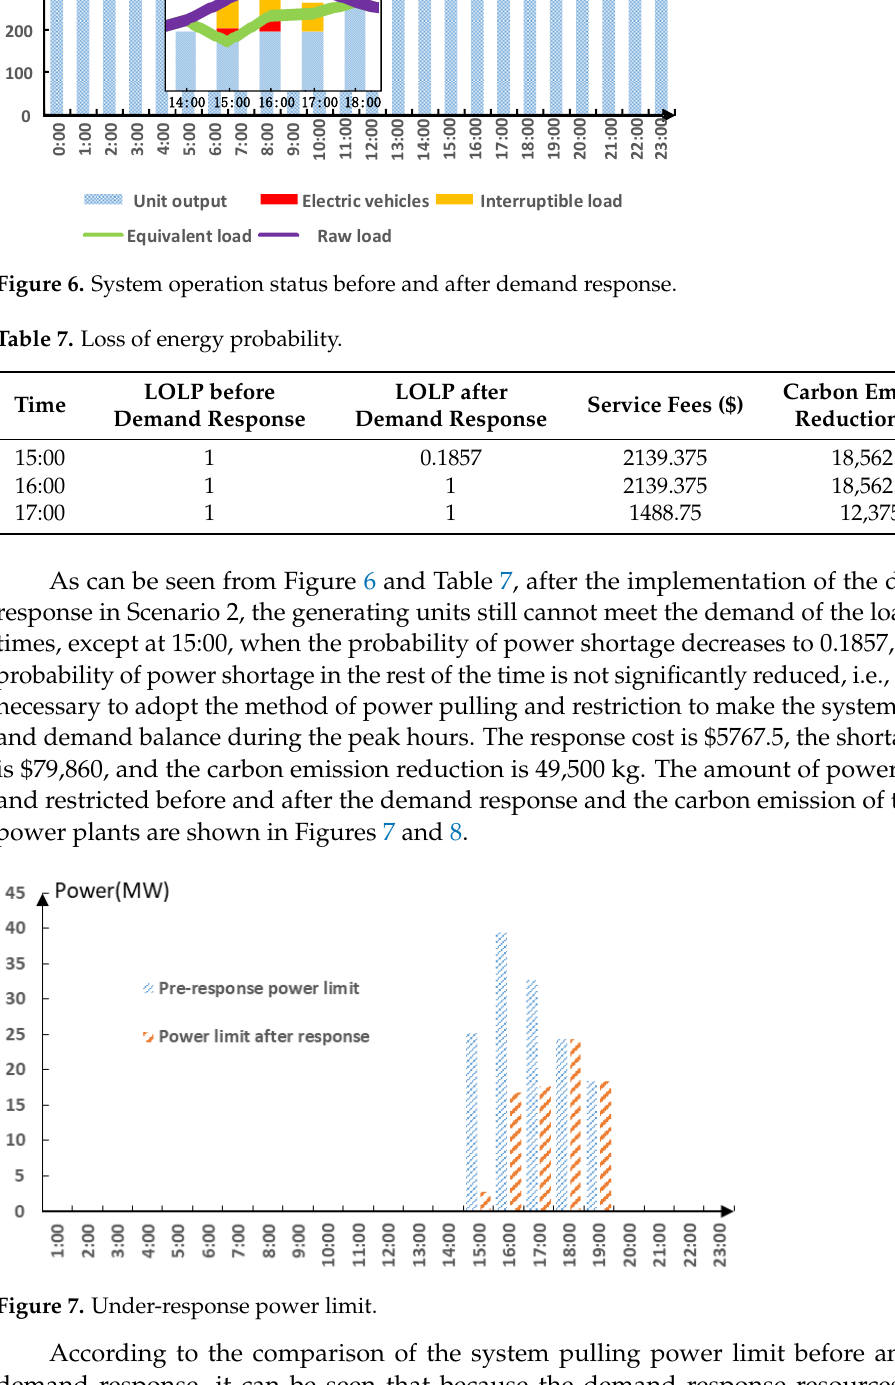
Figure 6. System operation status before and after demand response.